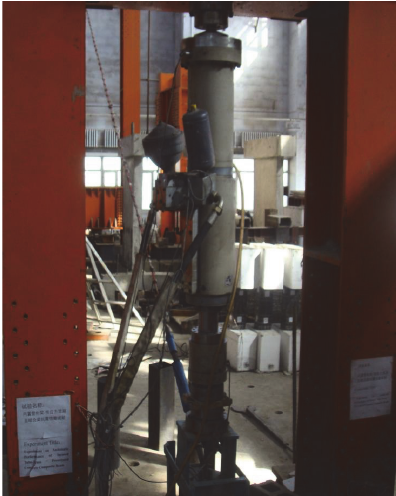
Figure 4: The photo of the field layout of cable parametric vibration test.